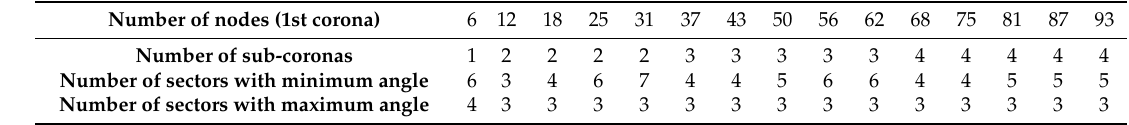
Table 2. Minimum and maximum number of sectors.